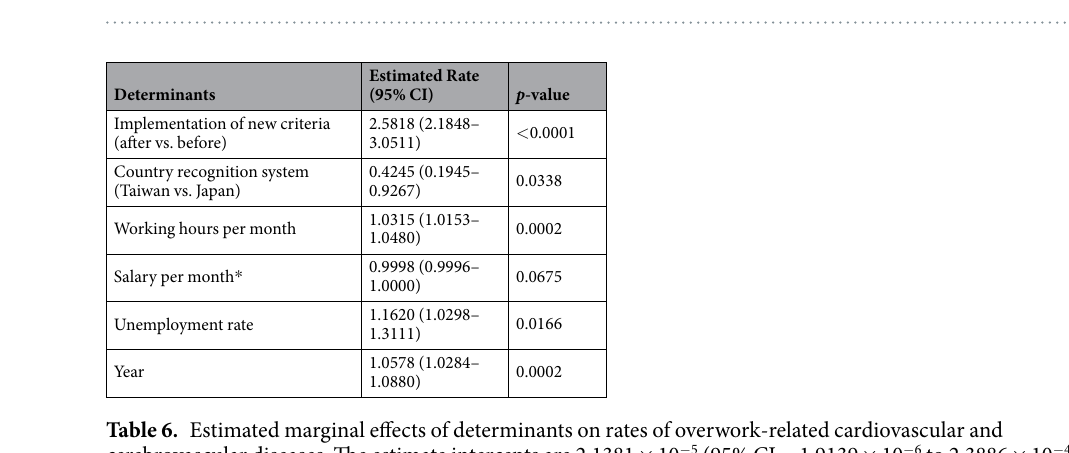
In order to estimate the potential effect of differences in the system for recognizing work-related diseases between the two countries, we further combined data of the two countries and repeated the analysis with an addi- tional covariate: “country recognition system.” Table 6 shows that the effect of implementing the new criteria was significantly associated with 2.58-fold ( p -value < 0.05) increases in the rate of overwork-related CVDs. We also found a significant effect for the “country recognition system” ( p -value < 0.05). Given similar working conditions and the formal implementation of the new criteria of recognizing overwork-related CVDs were similar across the two countries, the recognized rate in Taiwan was just 0.42-fold of the rate in Japan. This indicated that the recog- nition system in Taiwan was not as strong as it in Japan. Figure 1 shows the yearly time series for working hours per month (bars) and observed (solid lines) and predicted (dashed lines, based on the model in Table 6) rates of recognized overwork-related CVDs. While the average working hours in Taiwan were 20 or more hours per month more than in Japan, the rate of recognized overwork-related CVDs in both countries didn’t show an apparent difference. The gap between observed and predicted rates in Taiwan was more pronounced after the implementation of the new criteria. For example, if Taiwan reached the level of recognition system for work-related diseases of Japan and its working hours remained unchanged (i.e., 20 or more hours per months more than Japan), the predicted rates of overwork-related CVDs in Taiwan were 24.23–26.28 deaths per million employees per year, instead of the reported average of 11.48 deaths per million employees, for the periods 2011–2015.